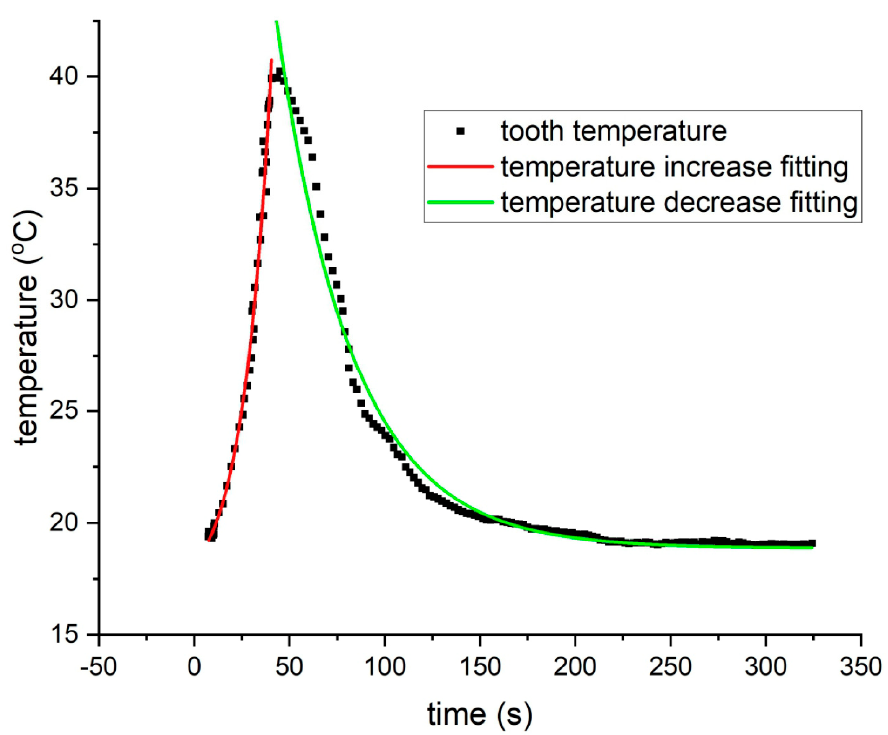
Figure 1. An example of the relationship between the premolar pulp chamber temperature (T) and the time (t) of polishing for a procedure performed with water cooling. Appl. Sci. 2020 , 10 , x FOR PEER REVIEW